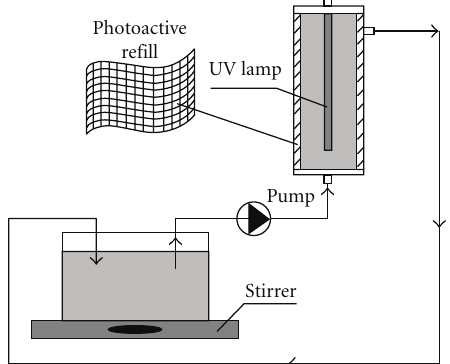
Figure 1: The scheme of installation for the process of photocat- alytic oxidation of